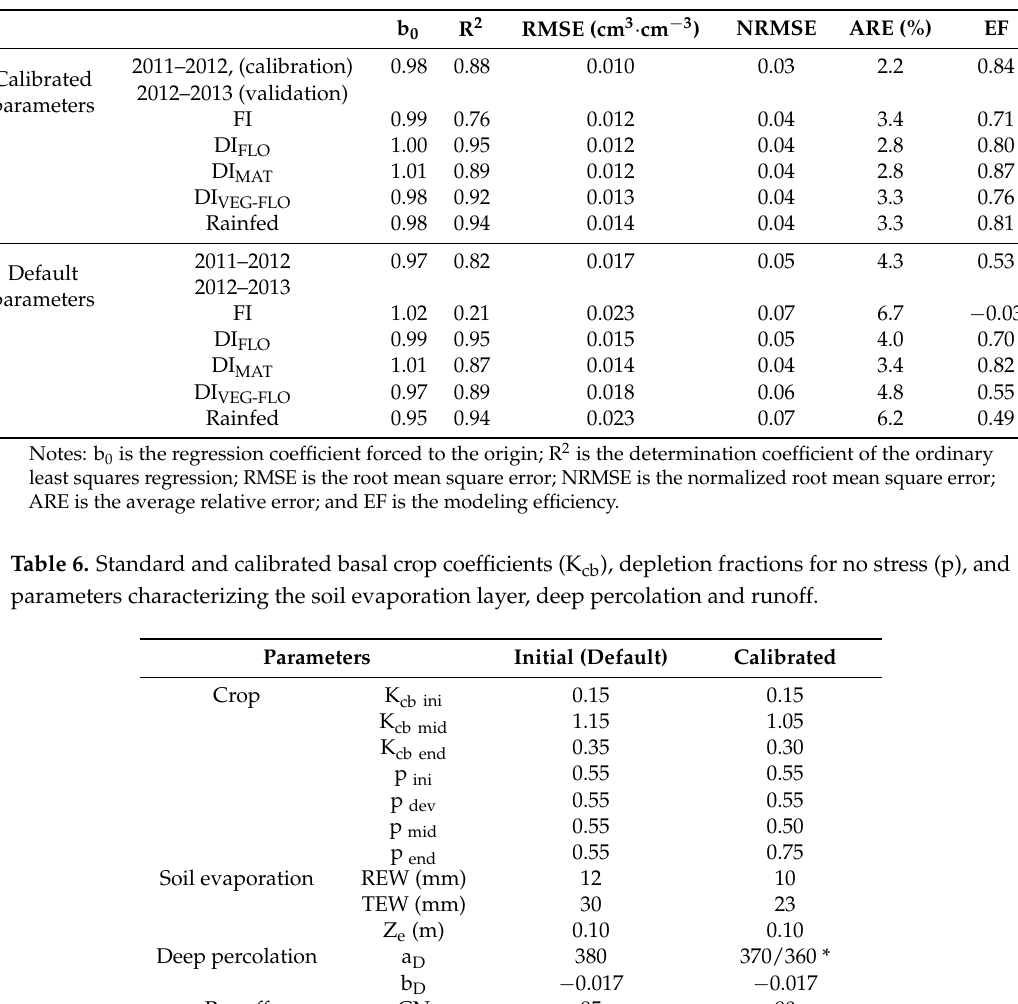
Table 5. Indicators of “goodness-of-fit” of SIMDualKc model applied to all treatments when using calibrated and default parameters.